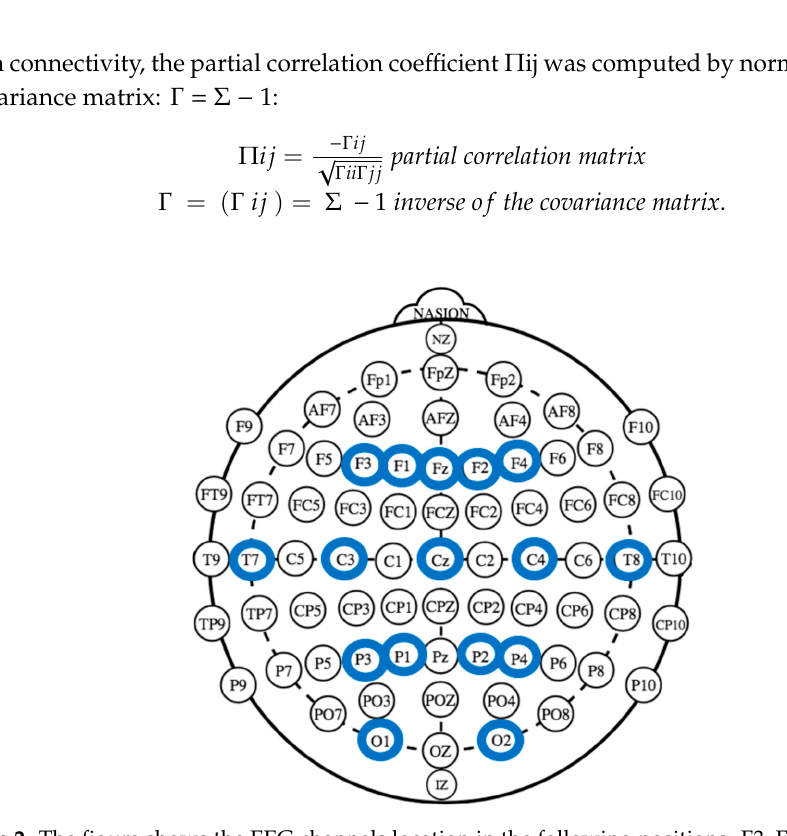
Figure 2. The figure shows the EEG channels location in the following positions: F3, F1, Fz, F2, F4, T7, C3, Cz, C4, T8, P3, P1, P2, P4, O1, and